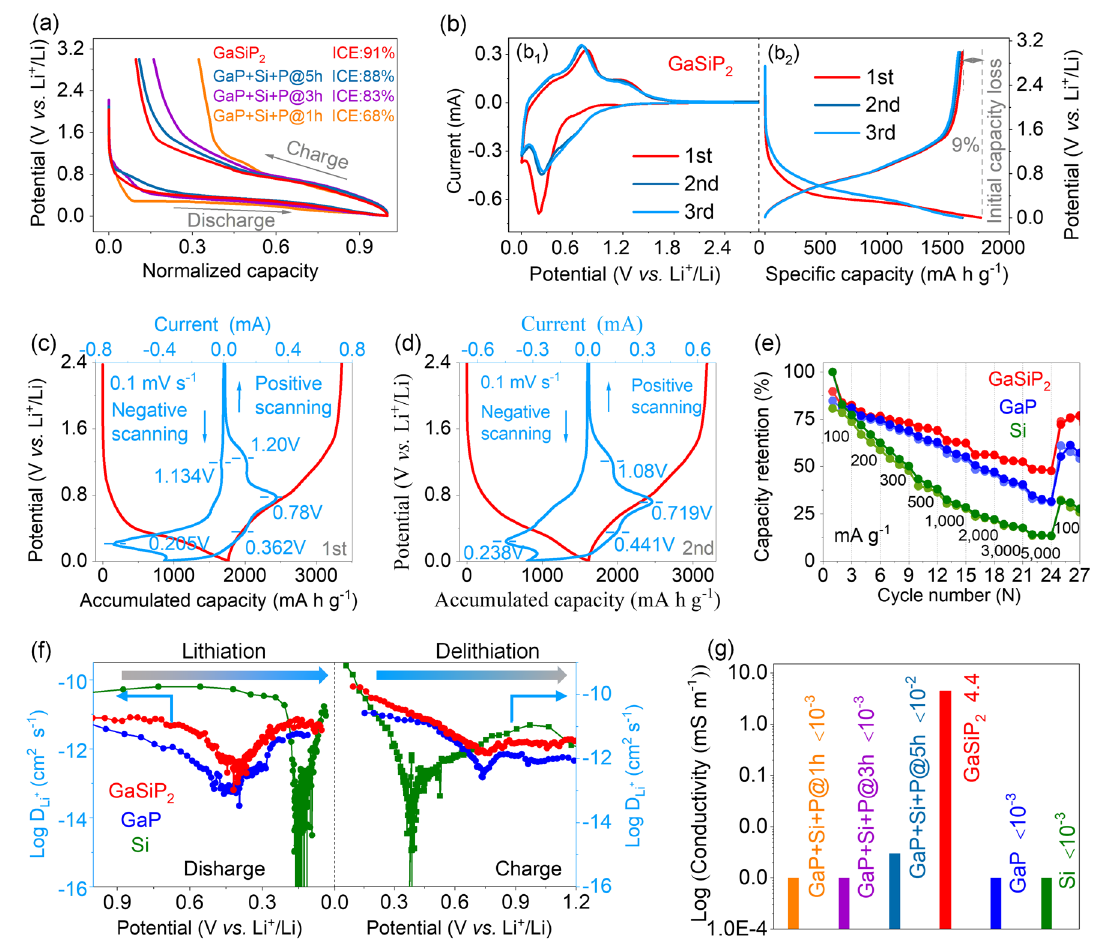
Fig. 4 a First discharge and charge profiles of the GaSiP 2 and ball milled intermediates of GaP + Si + P@ x h samples at a current density of 100 mA g −1 ; b initial three CV curves at a scan rate of 0.1 mV s −1 and first three discharge and charge profiles. CV curves along with the dis- charge and charge profiles: c First; d Second. e Rate performance; f Li-ions diffusion coefficient of the GaSiP 2 , GaP, and Si. g Electronic con- ductivity of the cation-mixed GaSiP 2 compound, the ball-milled intermediates of GaP + Si + P@ x h, GaP, and